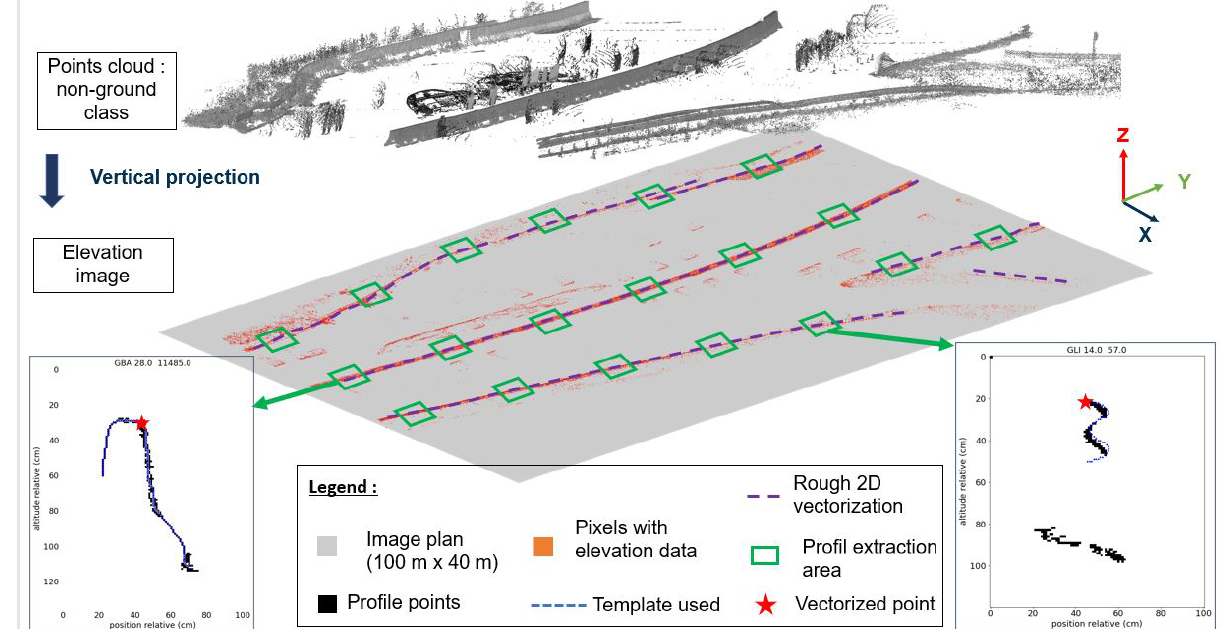
Figure 9. Guardrail extraction process.